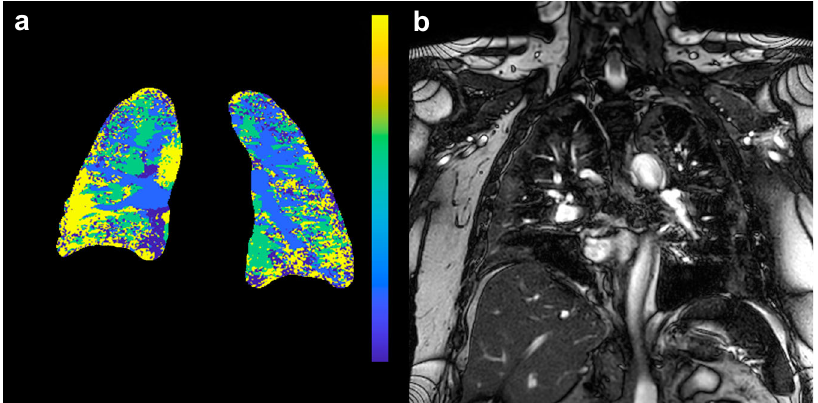
Fig. 2 MRI of a patient with COVID-19. a Time-to-peak map of the patient ’ s lung. The color lookup table has been set to maximum blue for pulmonary artery peak and yellow for aortic peak or later. Note large yellow areas dominating the periphery of the lungs, signifying late or no arrival of contrast. b Reference coronal T2-weighted scan to identify in fi ltrates. Reviewed together, perfusion disturbances are apparent both within lung in fi ltrates and in the normal-appearing pulmonary